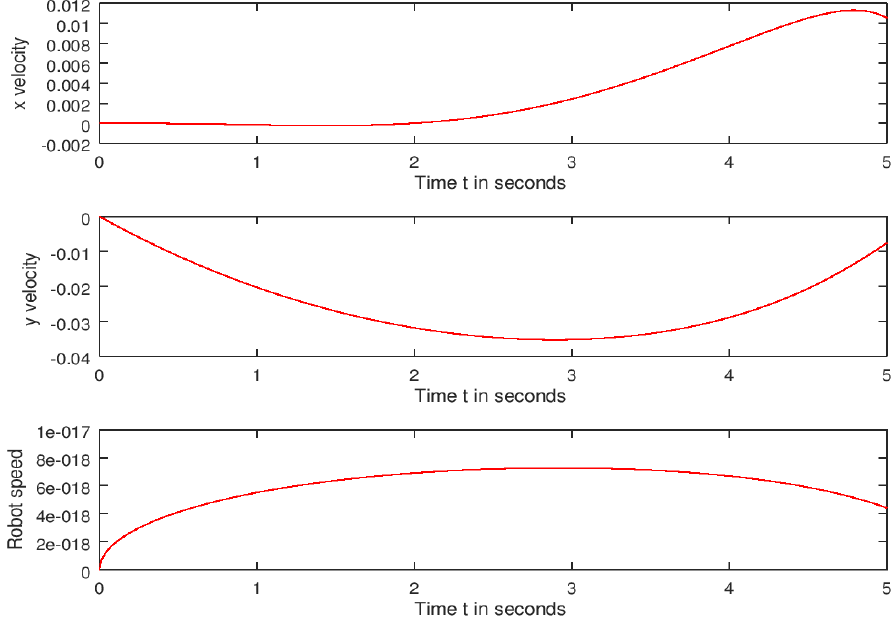
Figure 16. Feasible